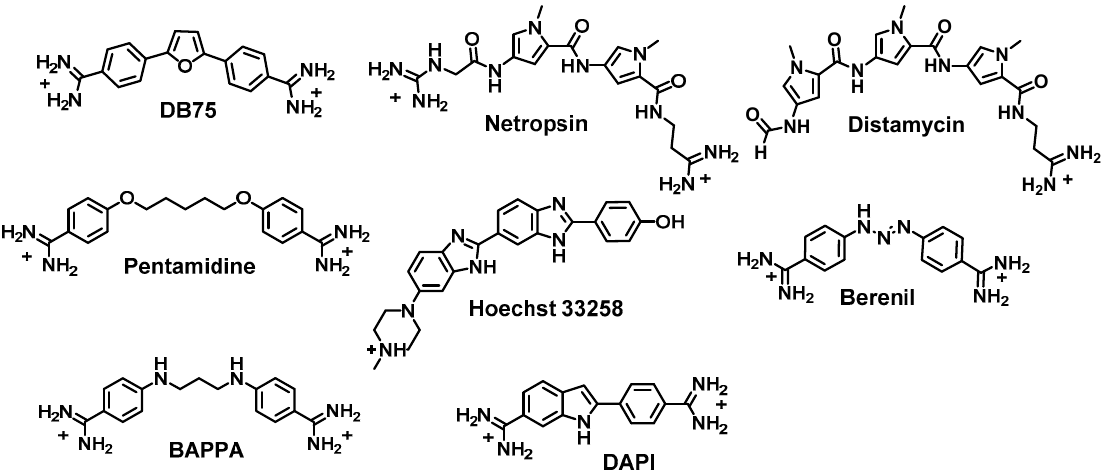
Figure 1. Structures of classical AT specific DNA minor groove binders.